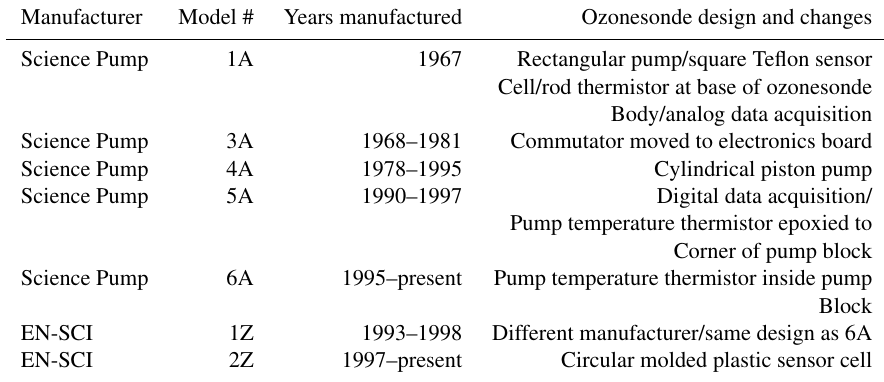
Table 1. Ozonesonde manufacturer, model, years manufactured, and design changes.